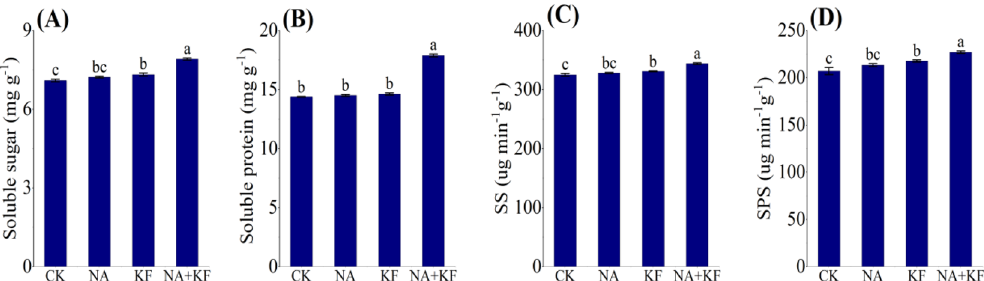
Figure 6. Effects of different treatments on soluble sugar, soluble protein, sucrose synthase and sucrose phosphate of tomato seedlings. ( A ) Soluble sugar, ( B ) soluble protein, ( C ) sucrose synthase (SS), ( D ) Sucrose phosphate synthase (SPS), NA, 5 mg·kg −1 NA; KF, 60 mg·kg −1 KF; NA + KF, 5 mg·kg −1 NA and 60 mg·kg −1 KF. Different lowercase letters denote statistical differences among treatments of tomato seedlings at the 5% level according to LSD test. Error bars above mean indicate standard error (n =